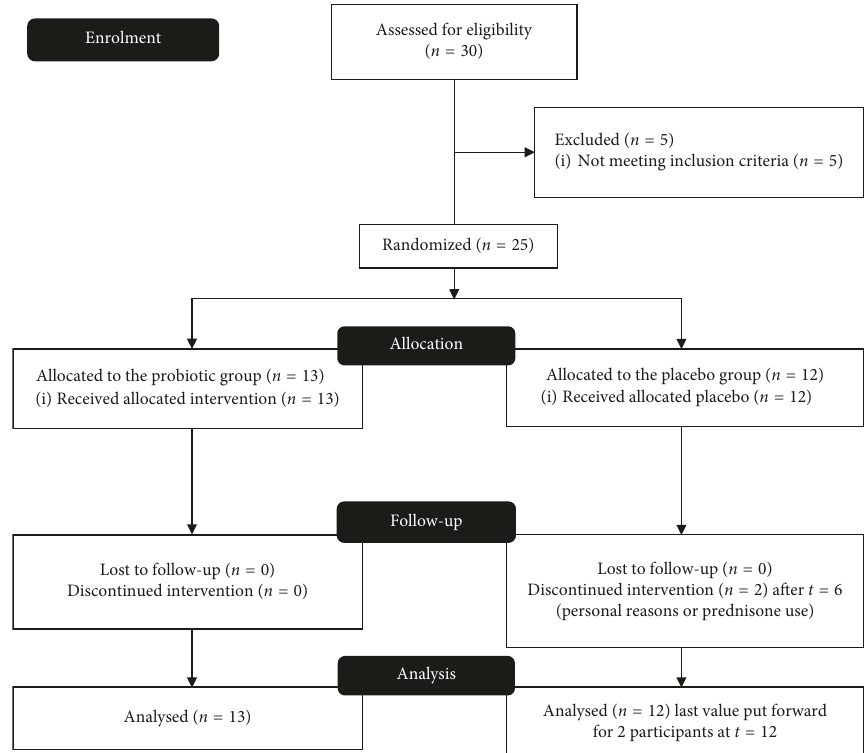
Figure 1: CONSORT flowchart for enrolment of participants and data analysis.